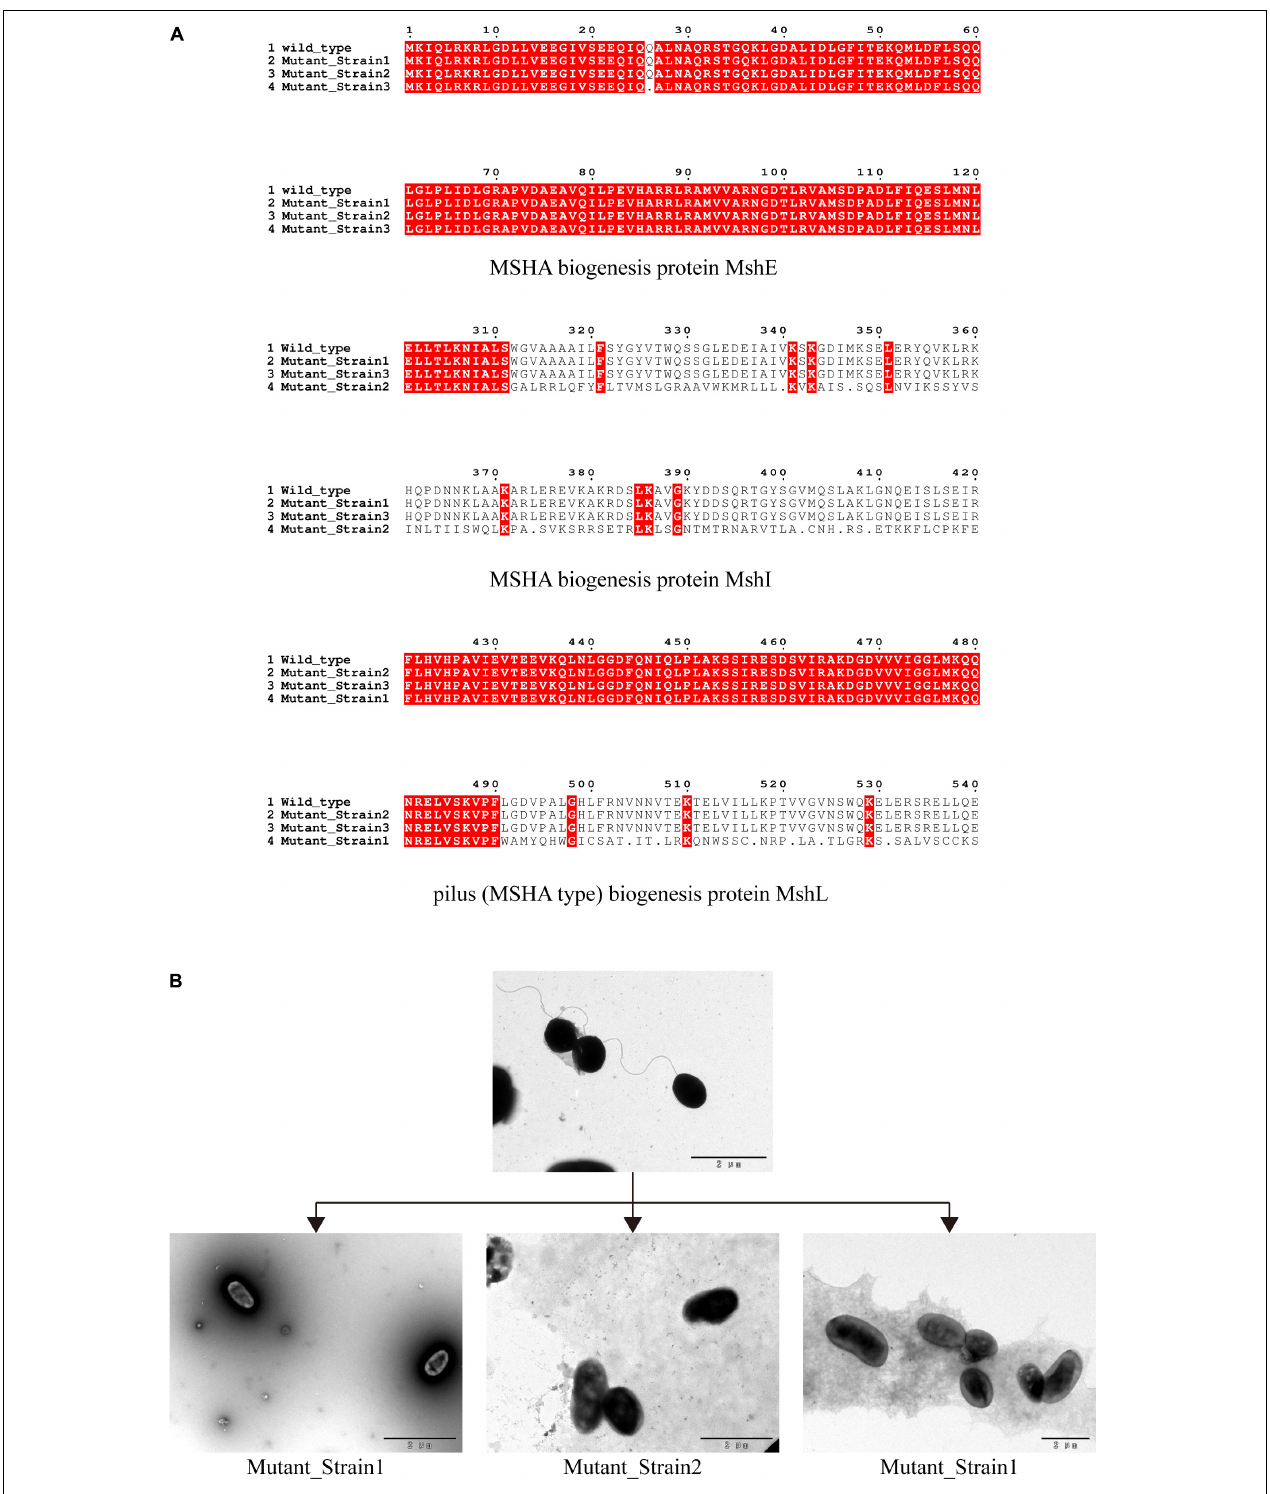
FIGURE 4 | Identification of phage recognition receptors based on coevolution. (A) Mutant strains tolerant to phage BUCT549, MSHA-like proteins affected by 100% mutated site. Mutant_Strain3 mutates at the 26th amino acid of MshE protein to produce a termination codon. Mutant_Strain2 has a deletion at amino acid 312 of the MshI protein, producing a stop codon at amino acid 340. Mutant_Strain1 has a deletion at amino acid 491 of the MshL protein, producing a stop codon at amino acid position 504. (B) Electron microscopic observation of the morphology of the host V. alginolyticus (with flagella) and three tolerate strains (without flagella).